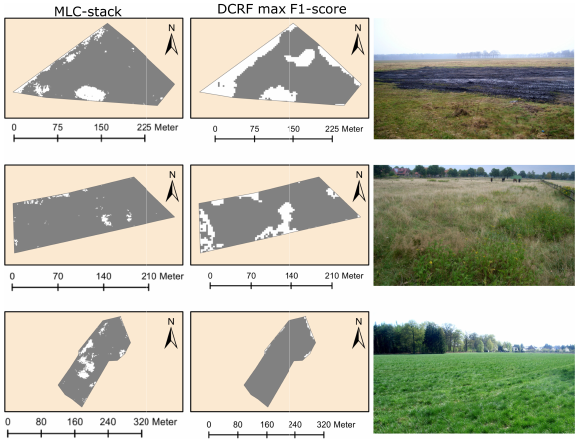
Figure 7. Scatterplot of DCRF max F1-score against MLC-stack completeness computed each grassland validation parcel.